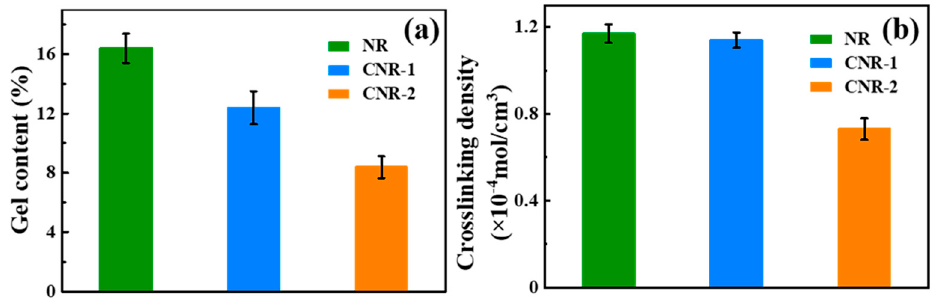
Figure 2. The variation of gel content ( a ) and crosslinking density ( b ) in NR before and after centrifugation.